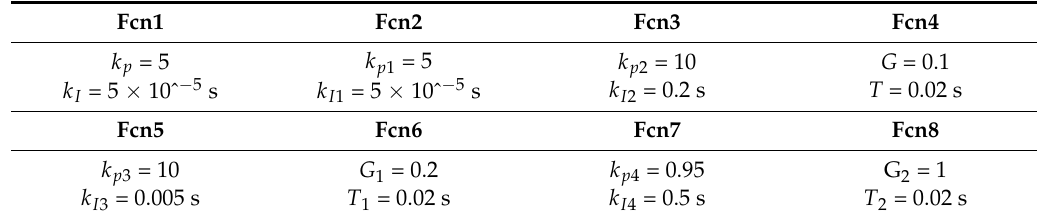
Table 2. Tuning parameters for the control